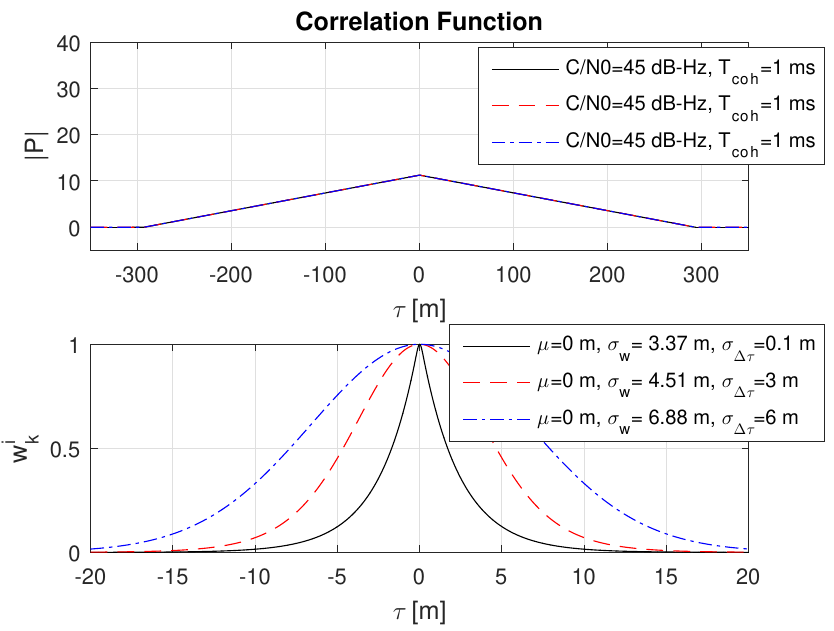
Figure 6. Impact of different code delay bias standard deviations σ ∆ τ on the weights w i integration time T coh = 1 ms. For the given conditions, only the weighted standard deviation σ w for σ ∆ τ = 6 seems to approach the theoretical lower limit of σ ∆ τ . In particular, σ ∆ τ = 0.1 can not be reached due to the influence of the low correlation time T coh at given C / N 0.